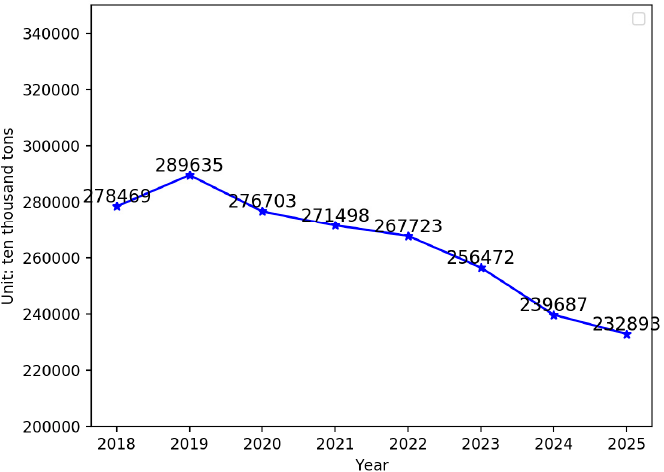
Figure 7. The forecasting results of coal consumption from 2018 to 2025 in China.